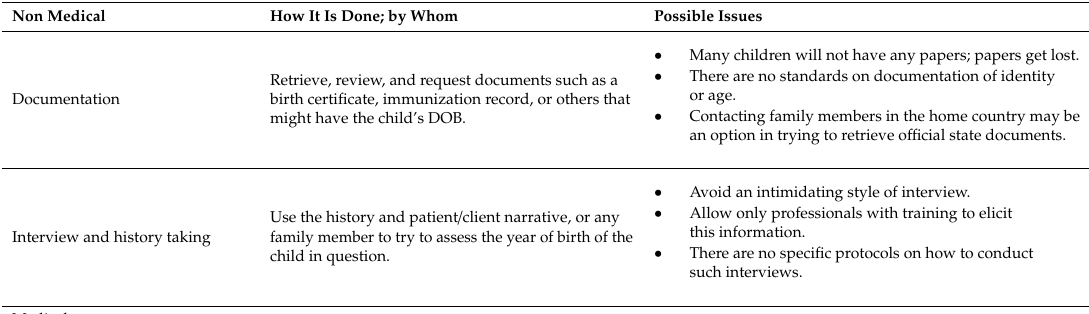
Table 1. Di ff erent methods for age